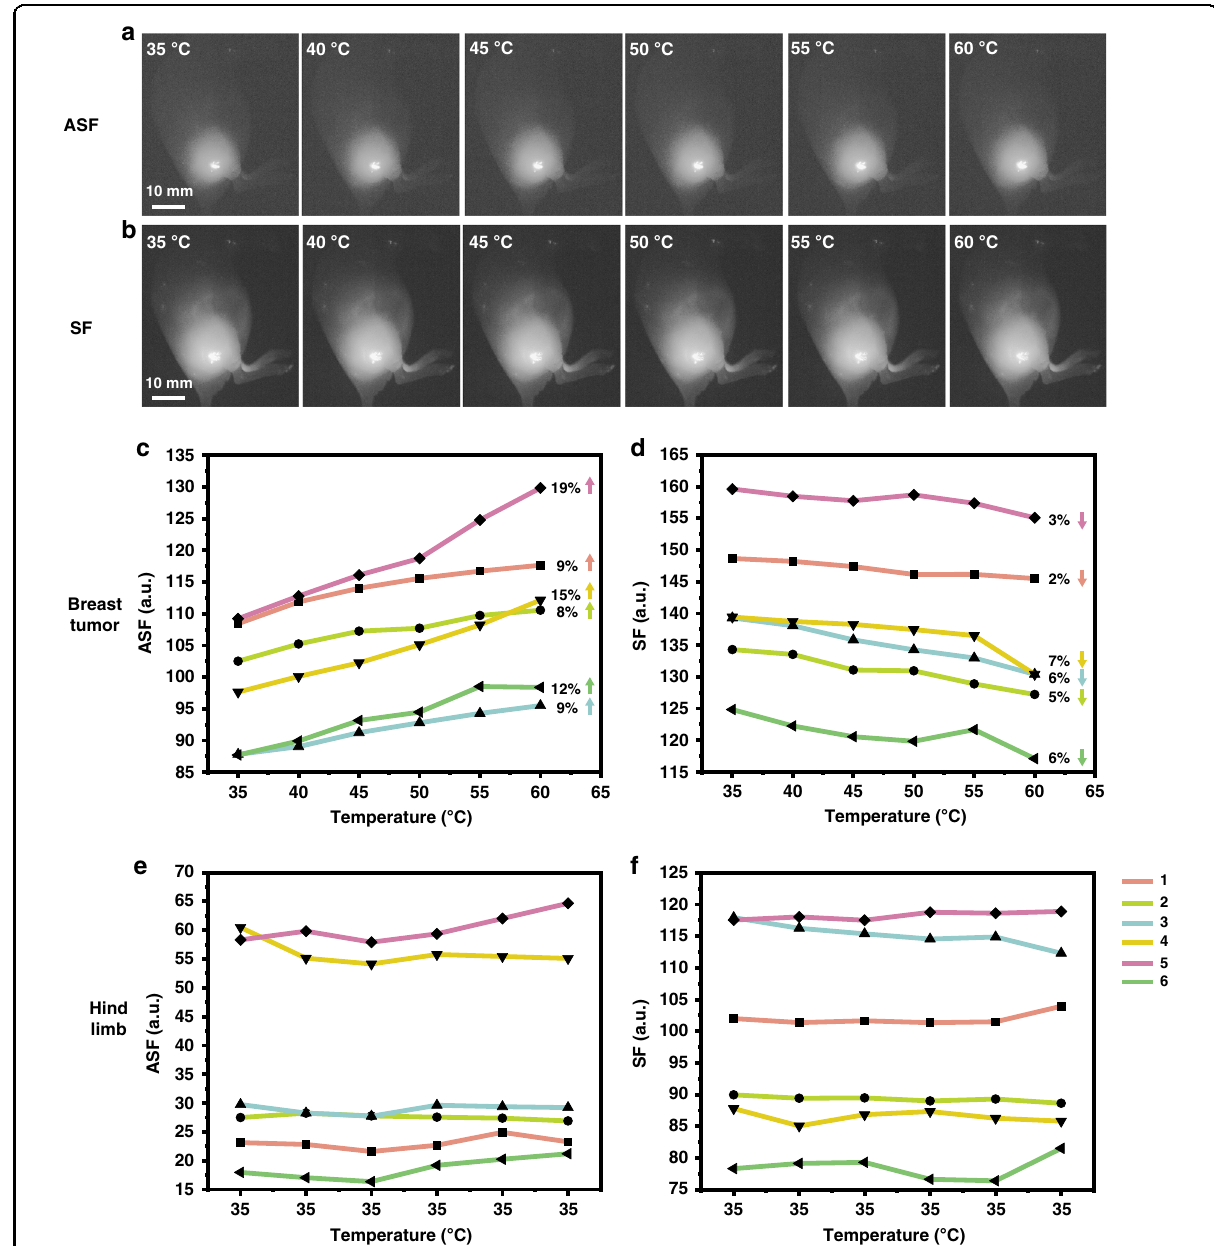
Fig. 2 Changes of ICG ’ s fl uorescence intensities in subcutaneous breast tumors of mice during photothermal treatment. Fluorescence images of one tumor mouse re fl ect the changes of ASF ( a ) and SF ( b ) intensities of ICG in the breast tumor with temperature. Excitation: 915 nm CW laser (40 mW cm − 2 ) for ASF, 793 nm laser (5 mW cm − 2 ) for SF; fl uorescence collection range: 850 – 900 nm; exposure time: 25 ms for ASF, 1.75 ms for SF. Scale bar: 10 mm. Changes of ASF ( c ) and SF ( d ) intensities of ICG in breast tumors of six mice with temperature. Dynamics of ASF ( e ) and SF ( f ) intensities of ICG in hind limbs of six mice under the condition of constant temperature (35 °C) as